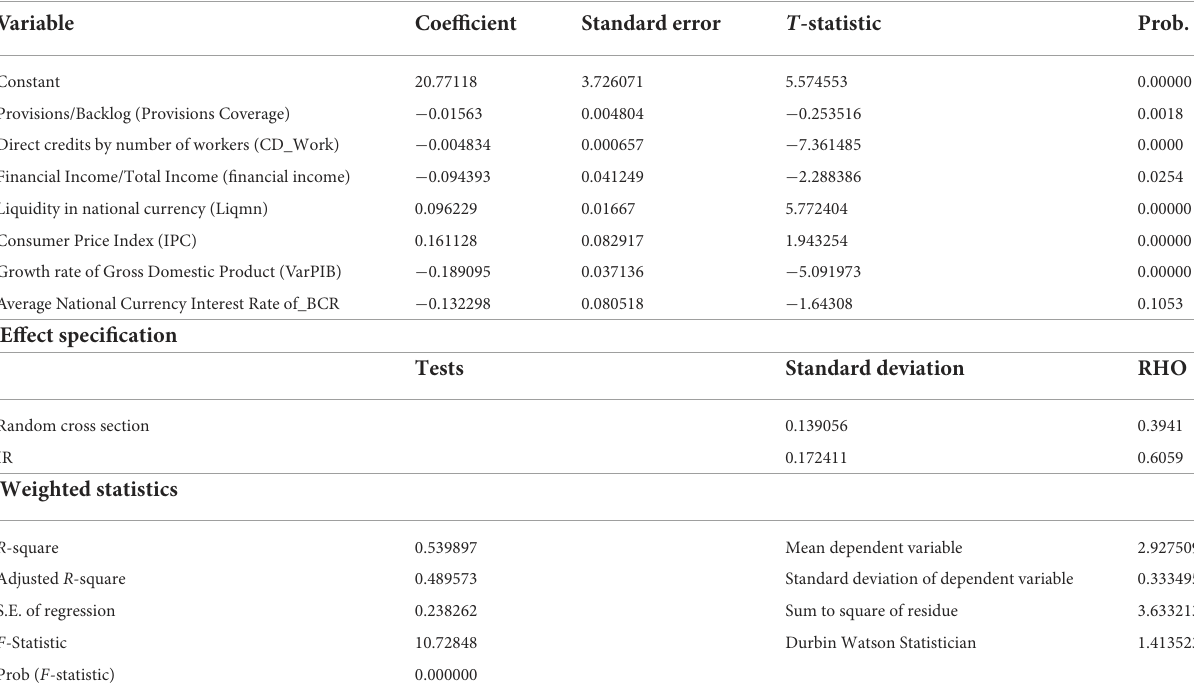
TABLE 2 Determinants of delinquency in financial